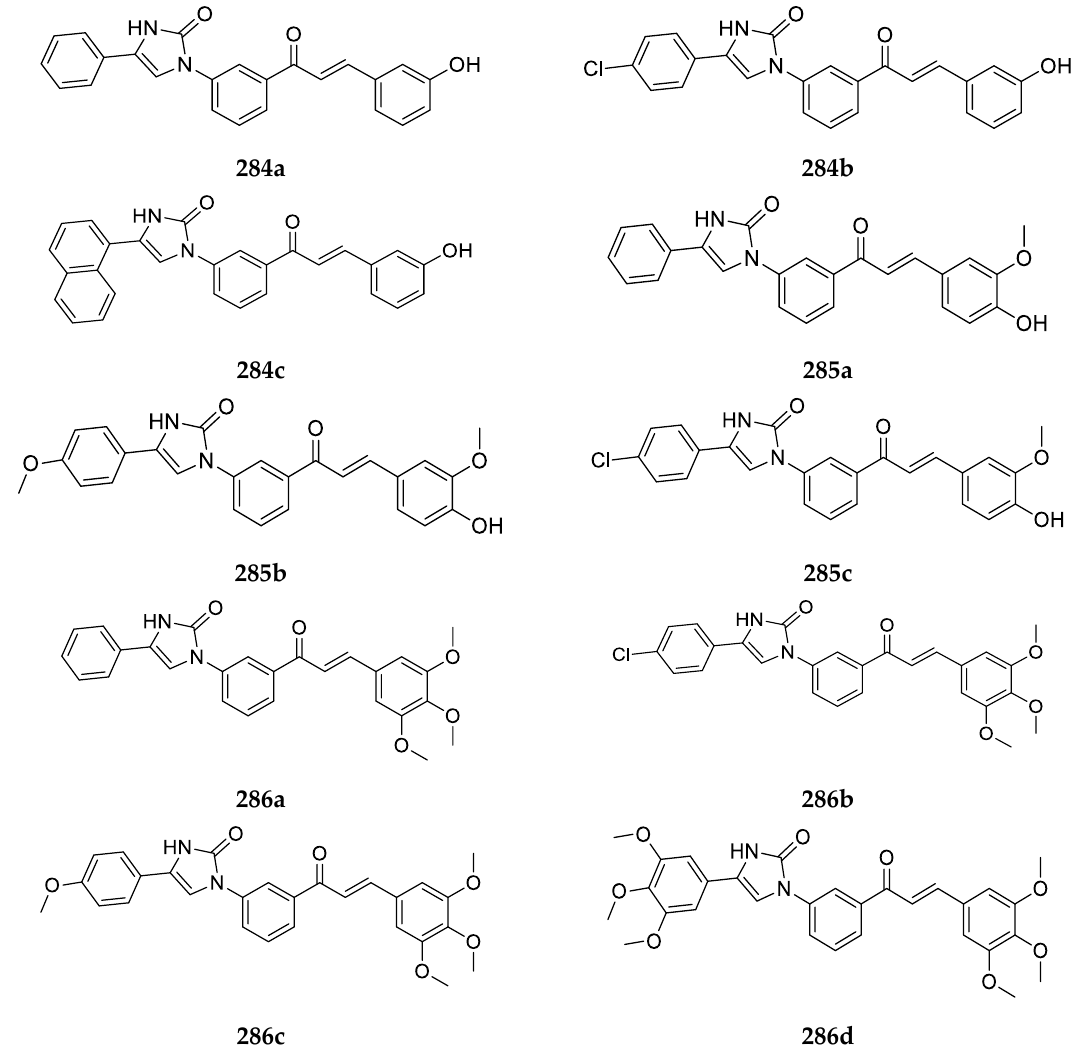
Figure 75. Chemical structure of 2-oxo-imidazol-1-yl-chalcone derivatives with substitution on ring B.